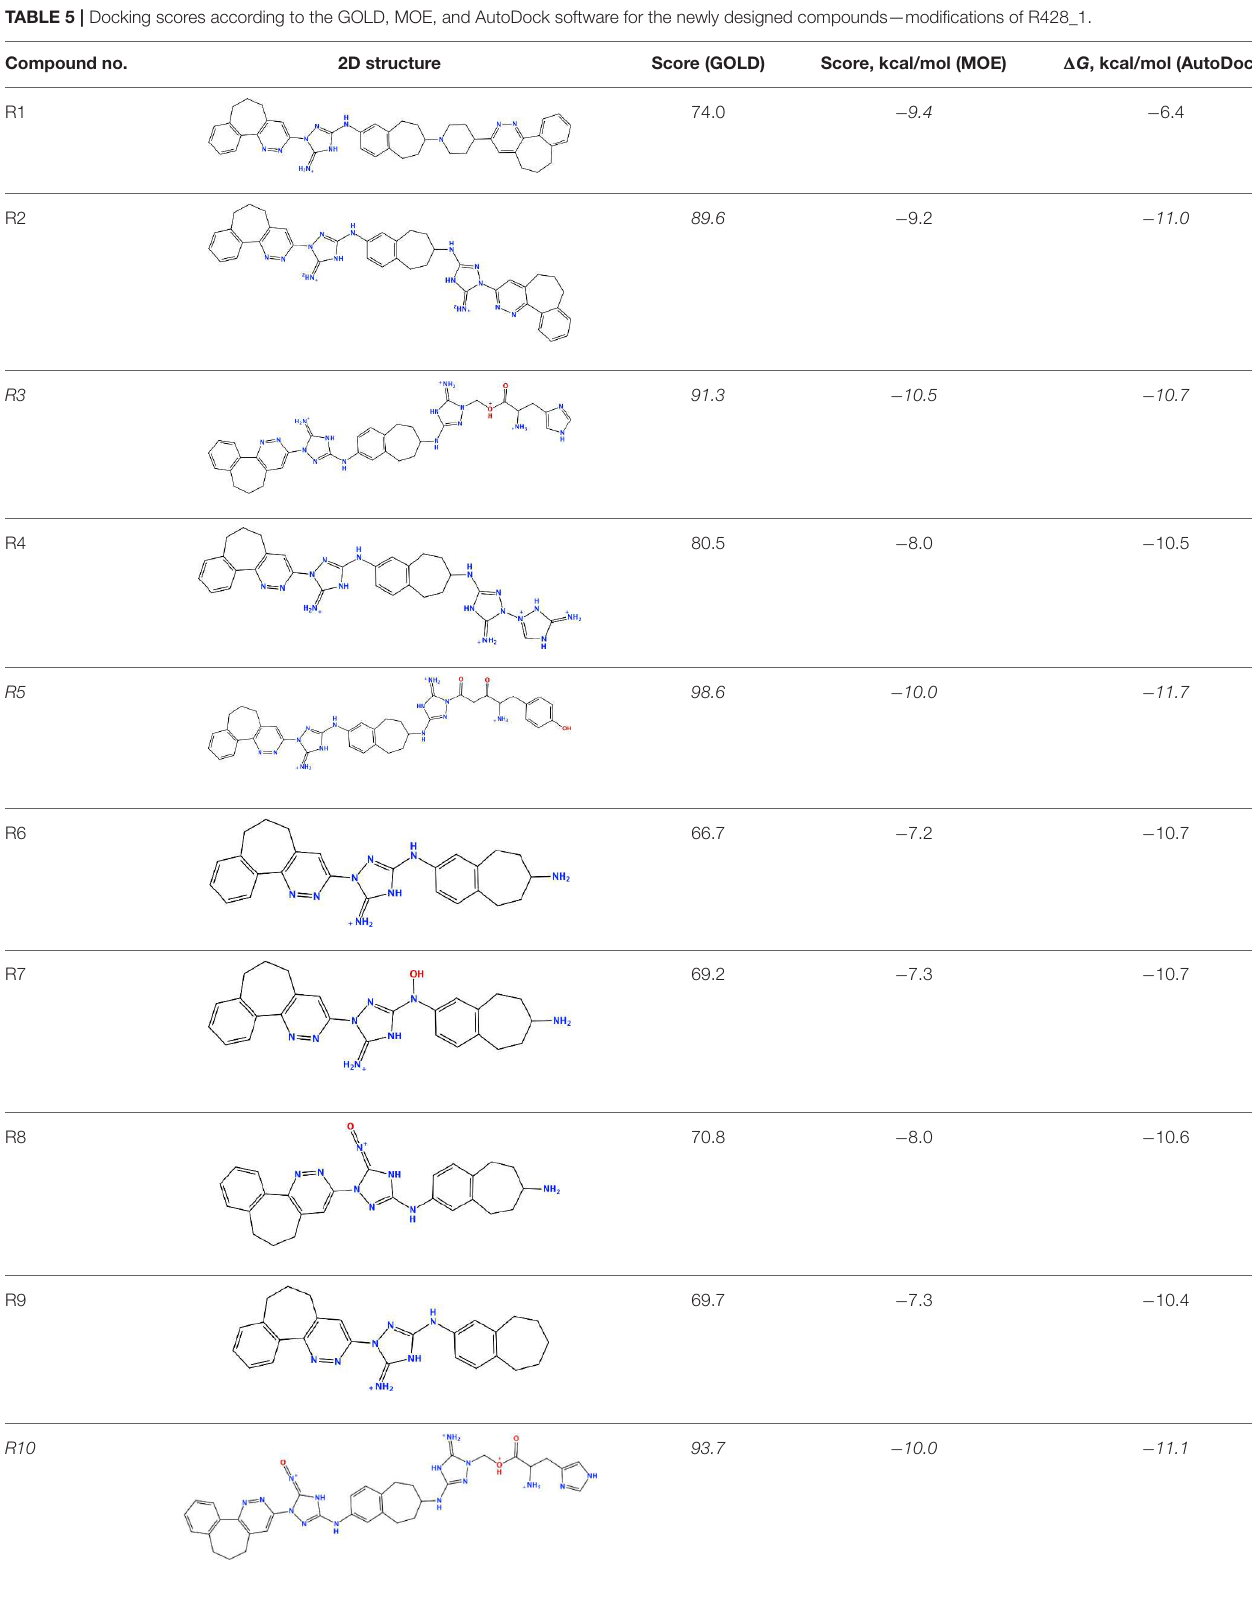
The top four scores are highlighted in